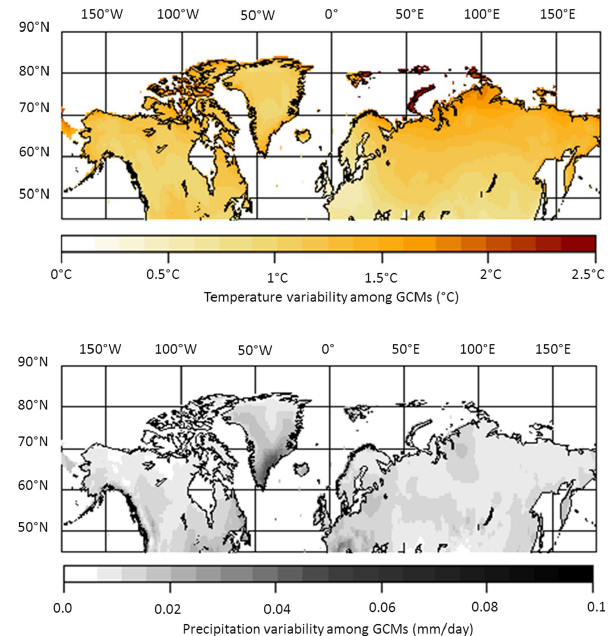
Fig. 2. The variability among the 19 GCMs for the values of (a) tem- perature ( ◦ C) and (b) precipitation (mmday − 1 ), plotted in Fig. 1 is demonstrated by the standard deviation.